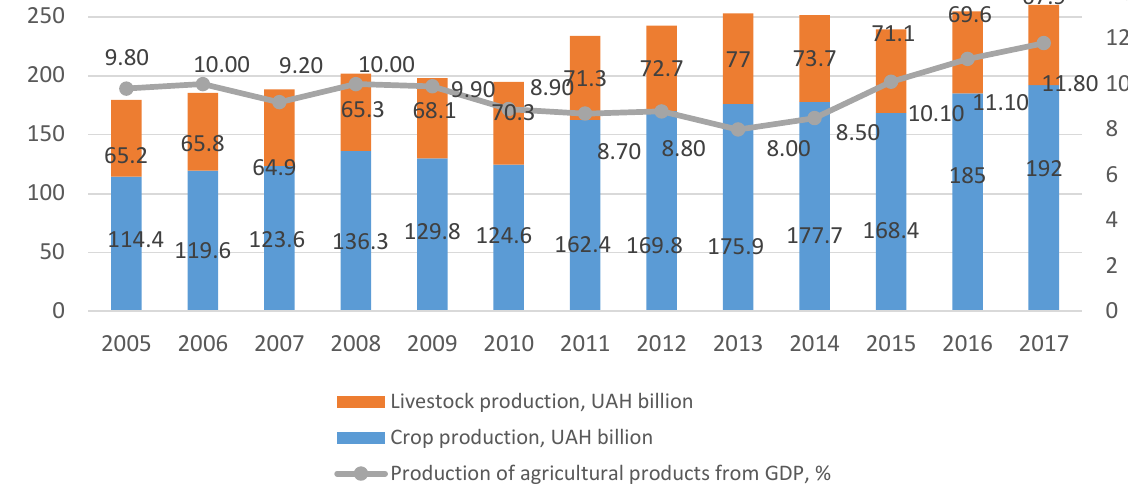
Figure 1. Production of agricultural products by sector and its share in GDP of